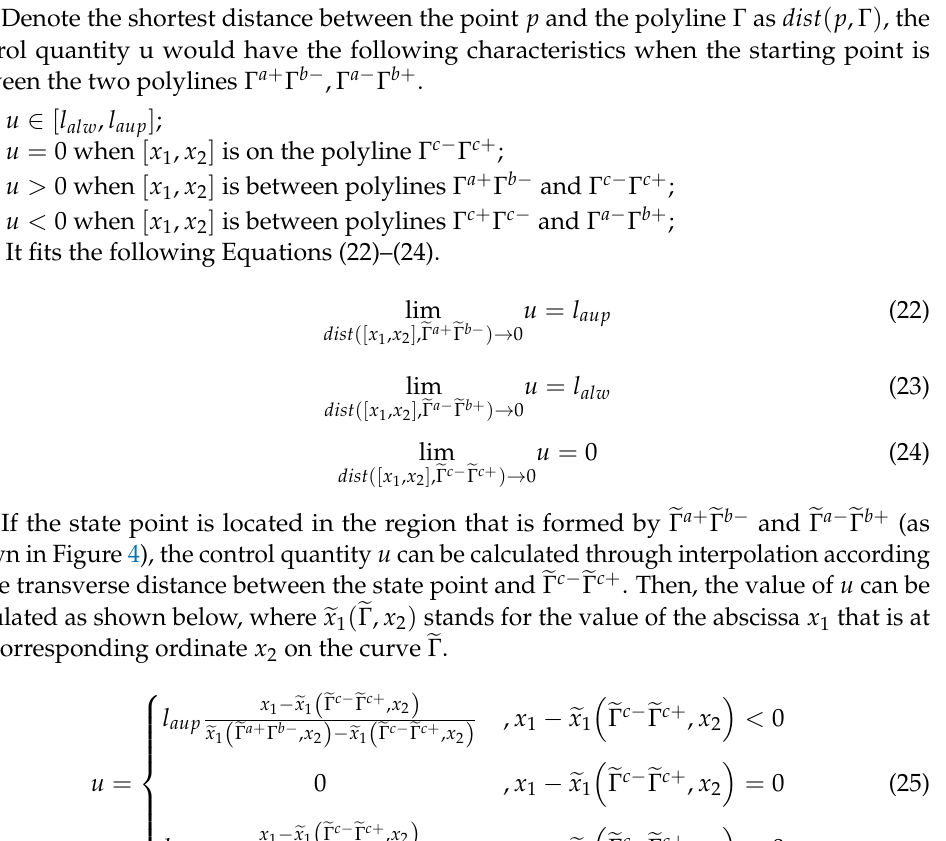
and point c − are both located at the origin 1 1 overlaps with point b − 1 , a + and b − on the phase plane are all − hl aup ; the 2 1 1 , a − and b + on the phase plane are 2 1 1